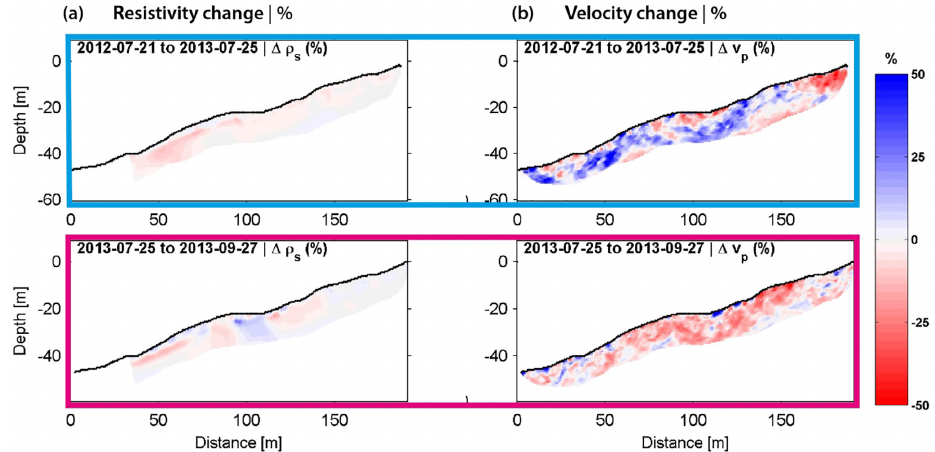
Figure 9. Temporal changes in (a) resistivity and (b) P-wave velocity between the measurements shown in Fig. 8. Upper panel: interannual changes between 21 July 2012 and 25 July 2013. Lower panel: seasonal changes between 25 July and 27 September 2013. The coloured rectangles correspond to the resistivity and velocity change patterns in the synthetic experiments (see Figs.